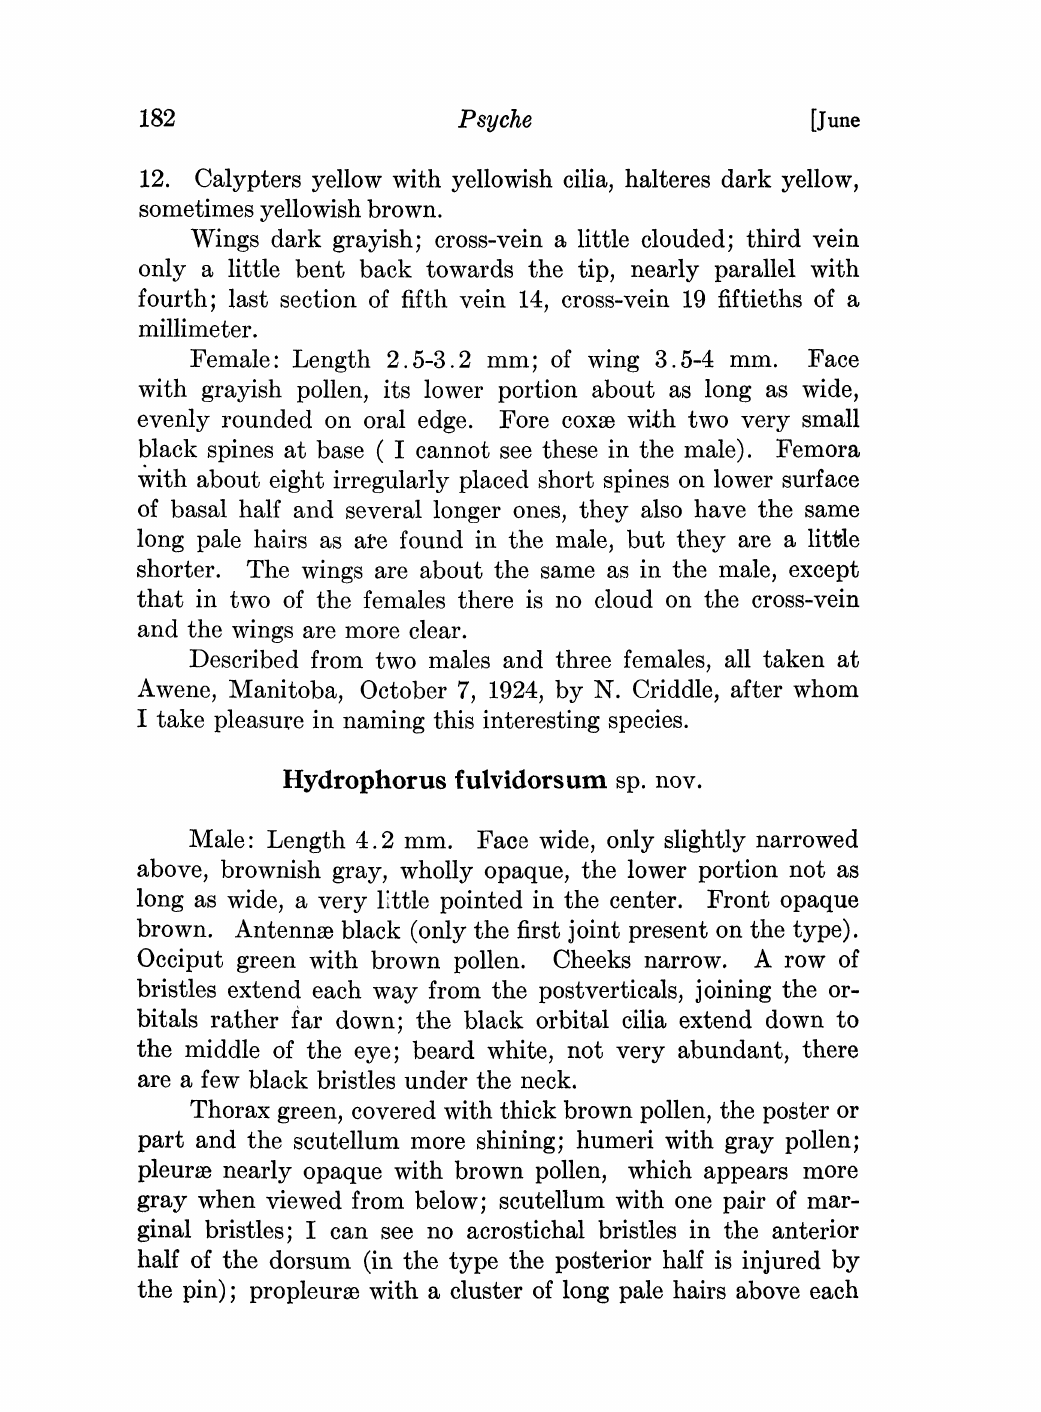
Calypters yellow with yellowish cilia, halteres dark yellow, sometimes yellowish